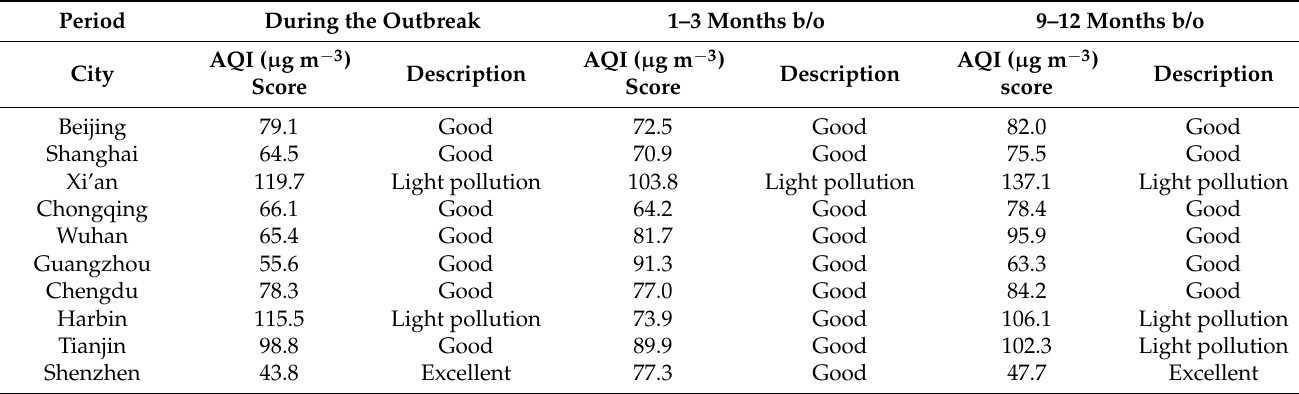
Table 3. Air quality in 10 mega-cities during the COVID − 19 outbreak, prior to the outbreak, and at a similar time in the previous year (based on average AQI